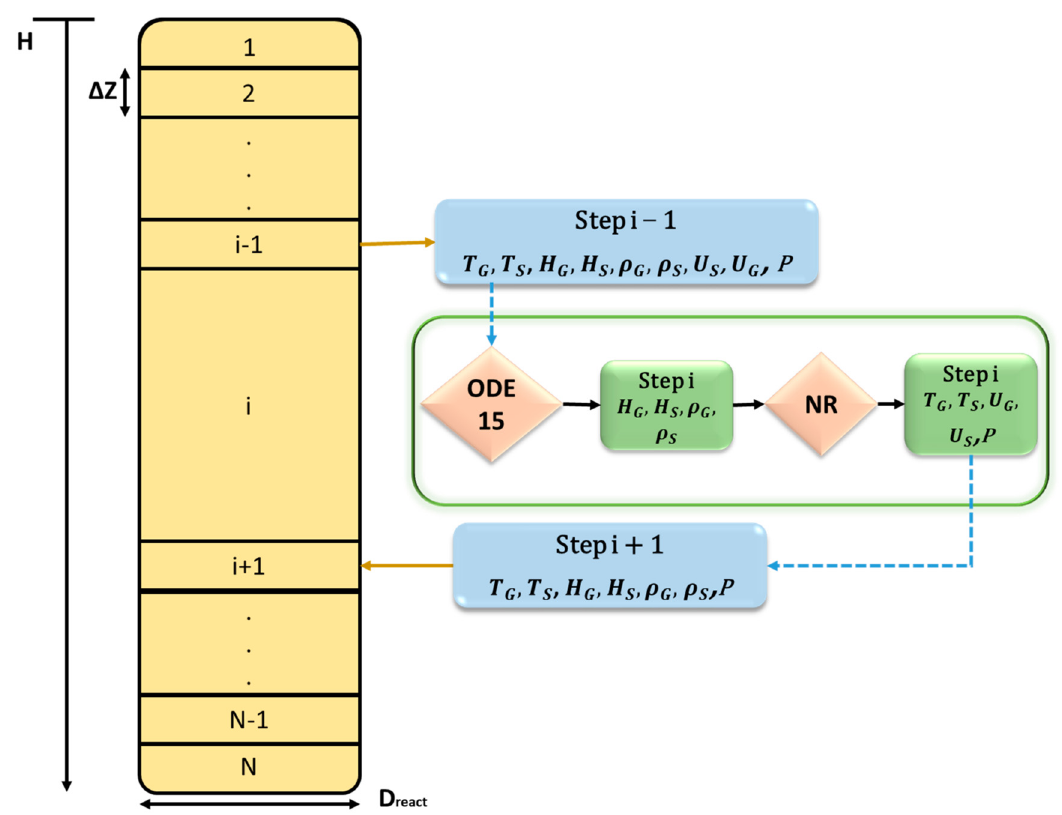
Figure 1. Reactor schematization for the mathematical